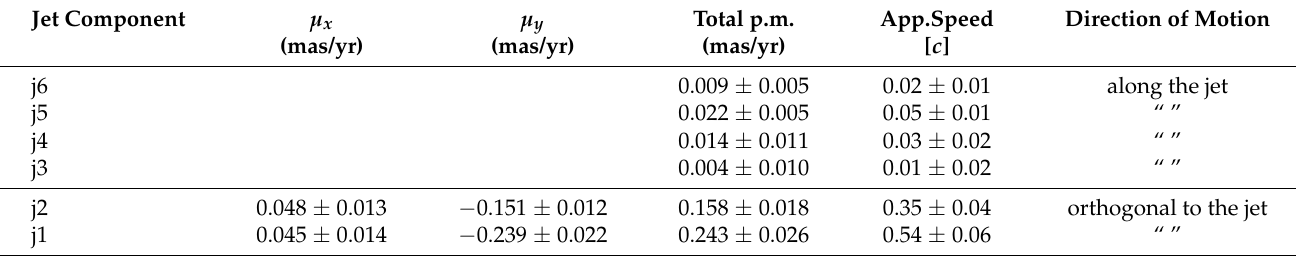
Figure 3. Temporal evolution of the separation from the core is shown for the moving jet components (j 1 , j 2 ) and for the stationary jet features (j 3 –j 6 ). The color scheme is the same as in Figure 2b. Unfilled squares (brown) denote jet features from the sheath structure and those jet features that could not be identified reliably. Dashed lines indicate a linear regression fit to the data points shown here. Table 2. Component identification, proper motion in the x-coordinate, proper motion in the y- coordinate, total proper motion, apparent speeds, and the direction of